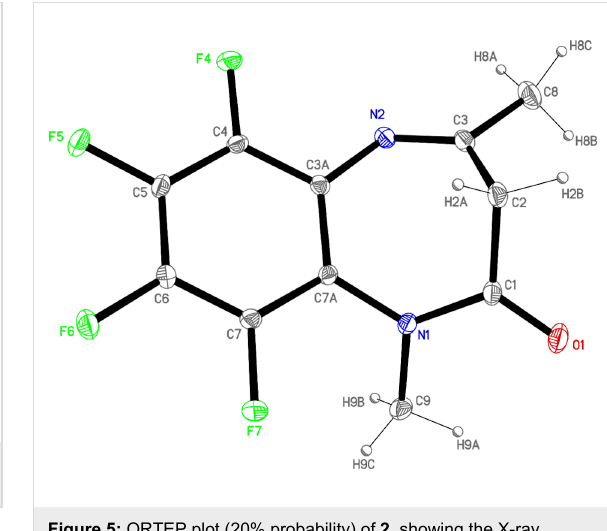
Figure 5: ORTEP plot (20% probability) of 2 , showing the X-ray labeling of the asymmetric unit. rings, with a shortest distance of 3.35(1) Å. The so formed double chains are isolated because of the above-mentioned steric